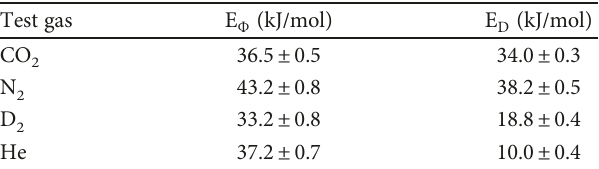
Figure 6: (a) Arrhenius plot of the gas permeability as obtained by analysis of the permeation fl ux value in stationary transport conditions. Permeability values are presented in practical units (Barrer). (b) Arrhenius plot of the gas di ff usivity as obtained by the fi tting of j curves; see Figures 5(a) – 5(d). Table 2: Activation energy for permeation E Φ and activation energy for di ff usion E as obtained by the Arrhenius plot of the D permeability and di ff usivity data in Figures 6(a) and